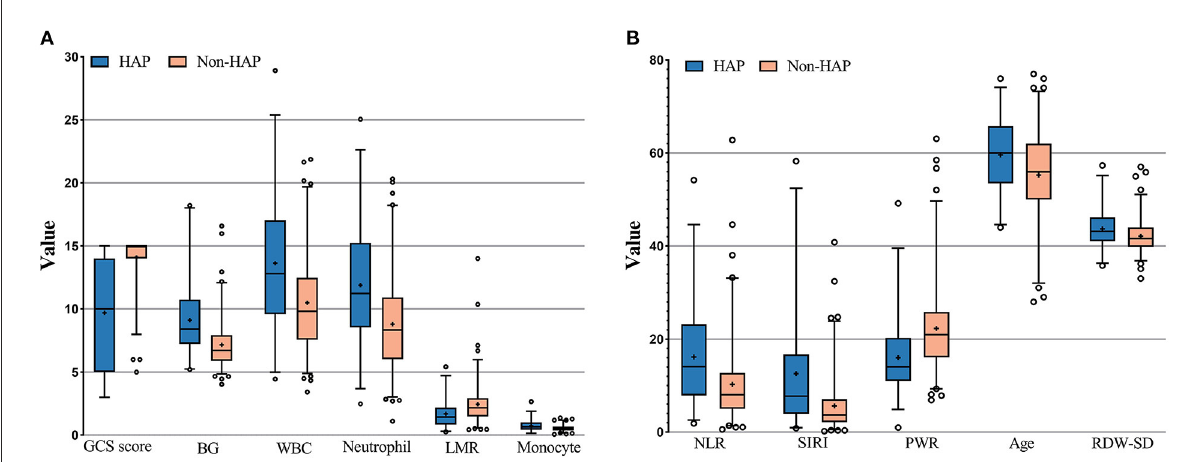
FIGURE2 (A,B) Measurement of the significant variables in univariate analysis; GCS score, Glasgow coma scale score; LMR, Leukocyte to monocyte ratio; NLF, neutrophil to lymphocyte ratio; SIRI, systemic inflammation response index; PWR, platelet to white blood cell ratio; RDW-SD, red blood cell distribution width standard deviation.